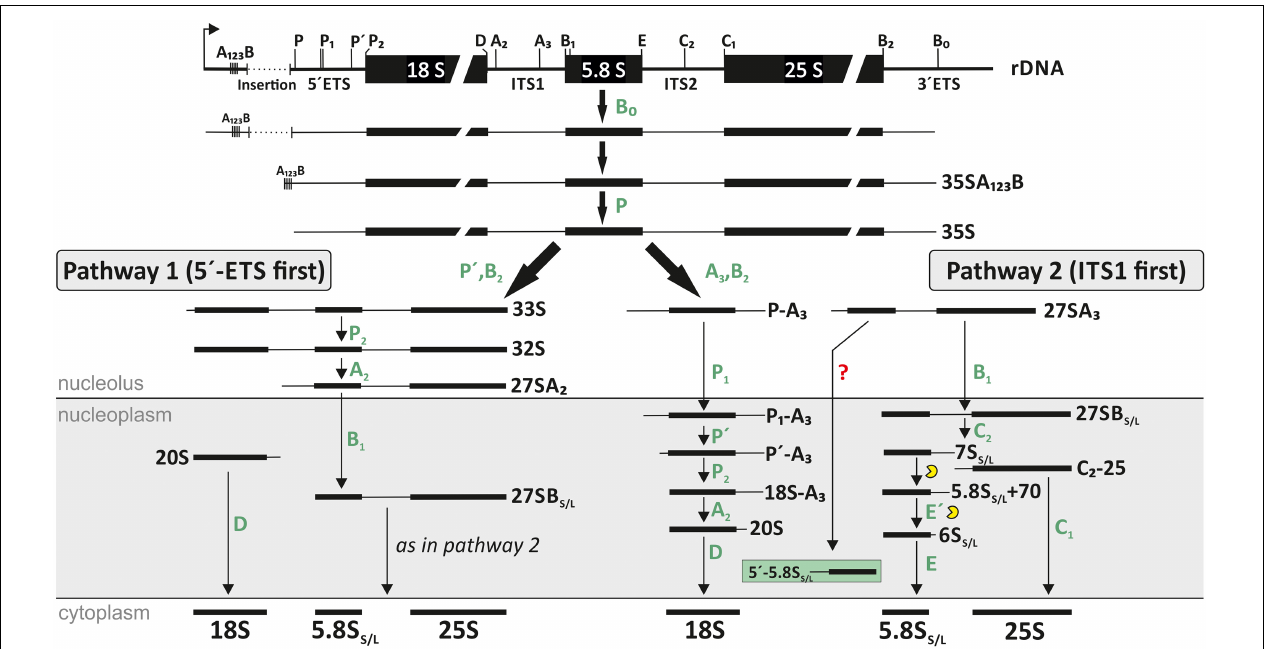
FIGURE 1 | Ribosomal RNA (rRNA) processing pathway in A. thaliana . After transcription the 35S pre-rRNA is formed. After cleavage at site P, the further processing depends on the next cleavage site. While for pathway 1 the next cleavage occurs in the 5 (cid:48) -ETS (similar to the main pathway in yeast), the second and majorly used pathway is characterized by a first cleavage in the ITS1 region (similar to the human pathway). The location of each existing precursor of Arabidopsis is shown. However, the exact localization of 27S and 18S precursors are not fully analyzed yet. The figure was modified from Weis et al.